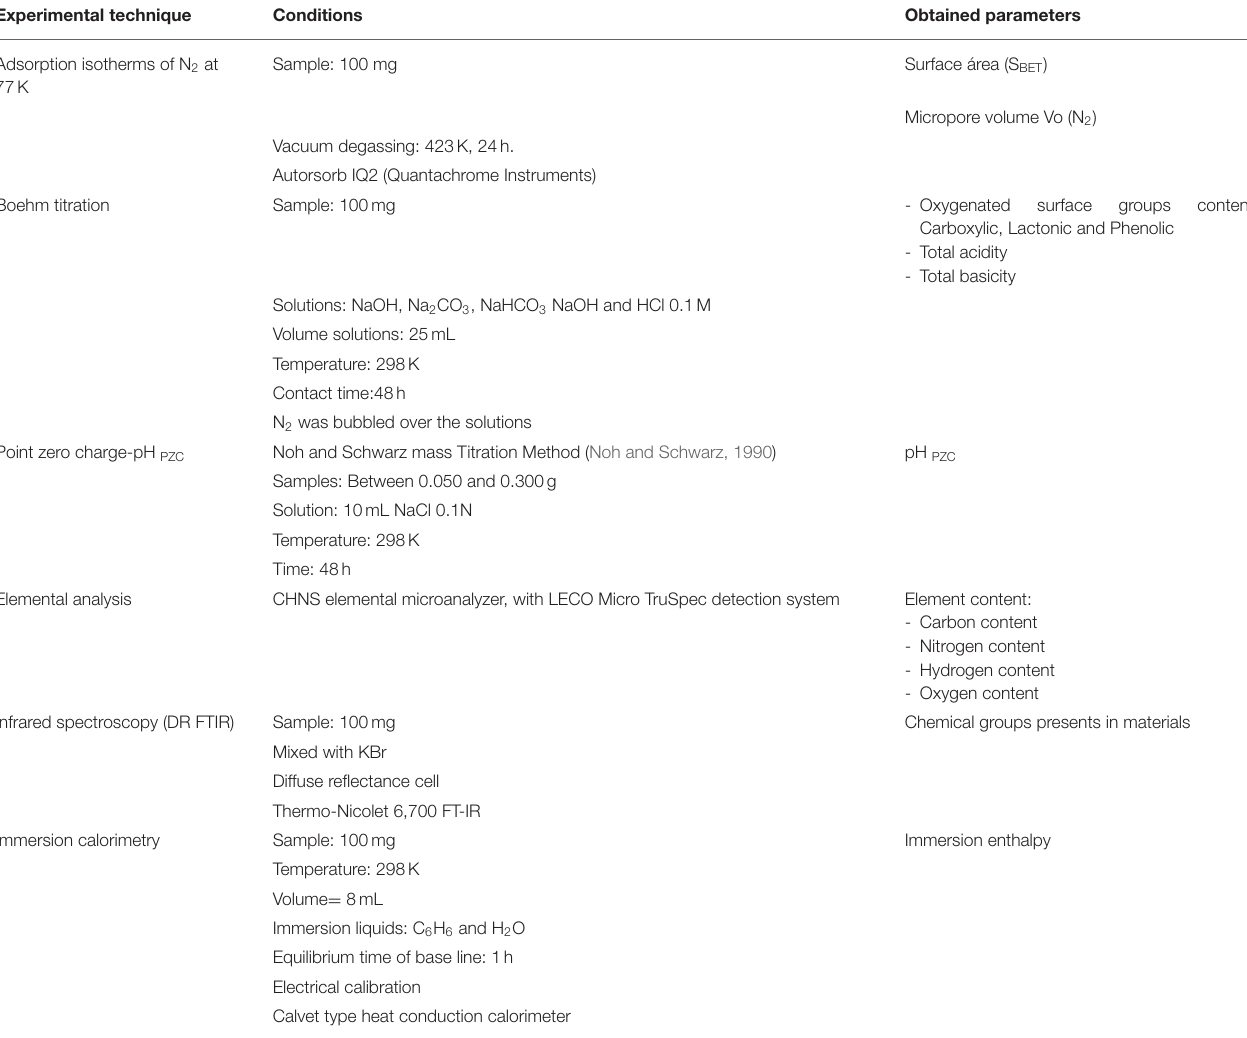
TABLE 1 | Techniques used in the characterization of activated carbons. Experimental technique Conditions Obtained parameters Adsorption isotherms of N 2 at 77K